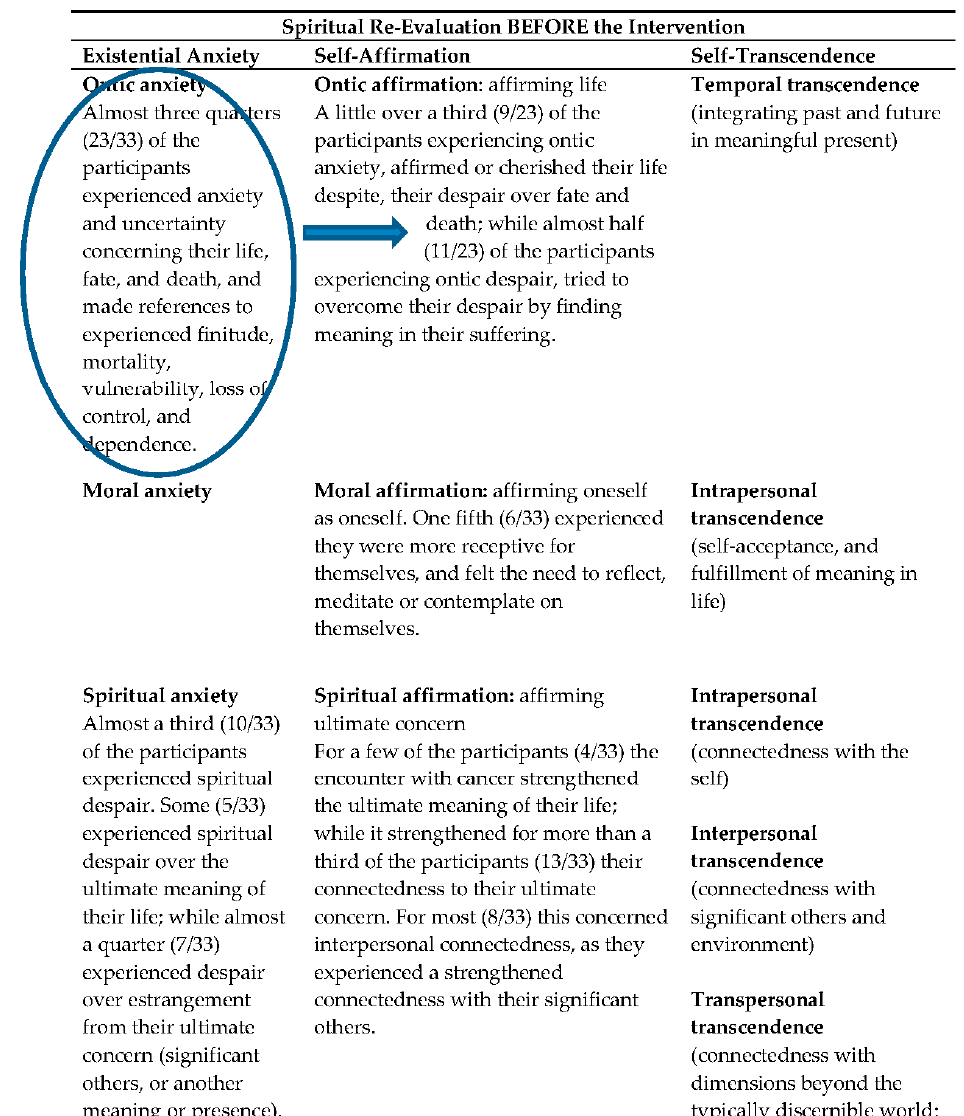
Table 4. Spiritual re-evaluation before the intervention.